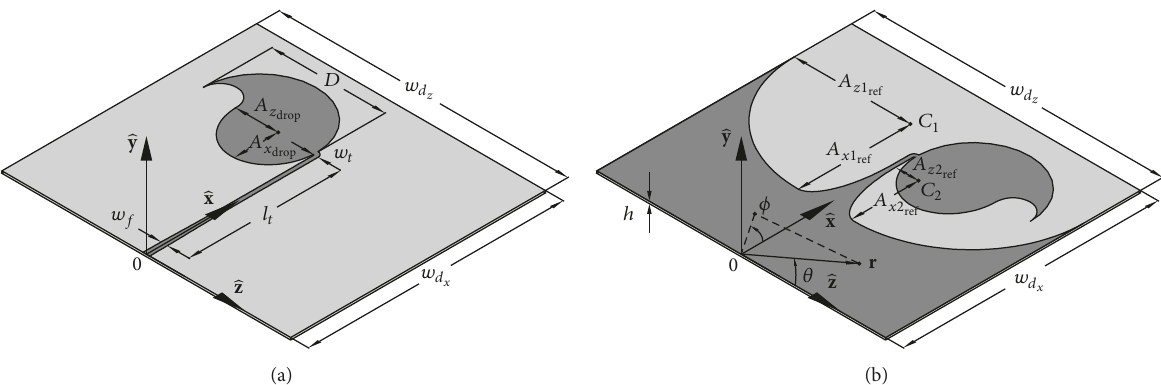
Figure 1: Geometry of the drop-shaped antipodal dipole antenna equipped with a metal reflector: (a) upper face, (b) top view of the lower face. The reference system used to analyse the radiating structure is also shown.